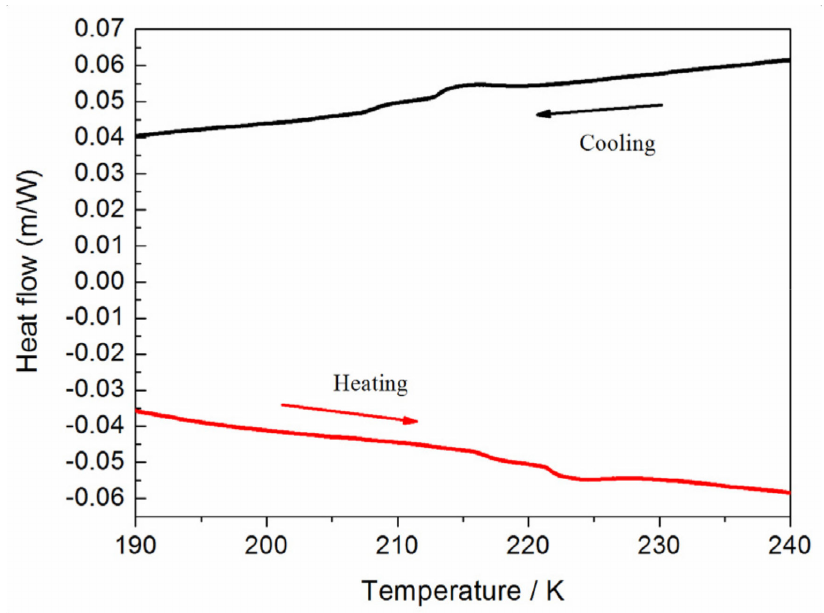
Figure 1. Di ff erential scanning calorimetry curves of 1 recorded upon heating and